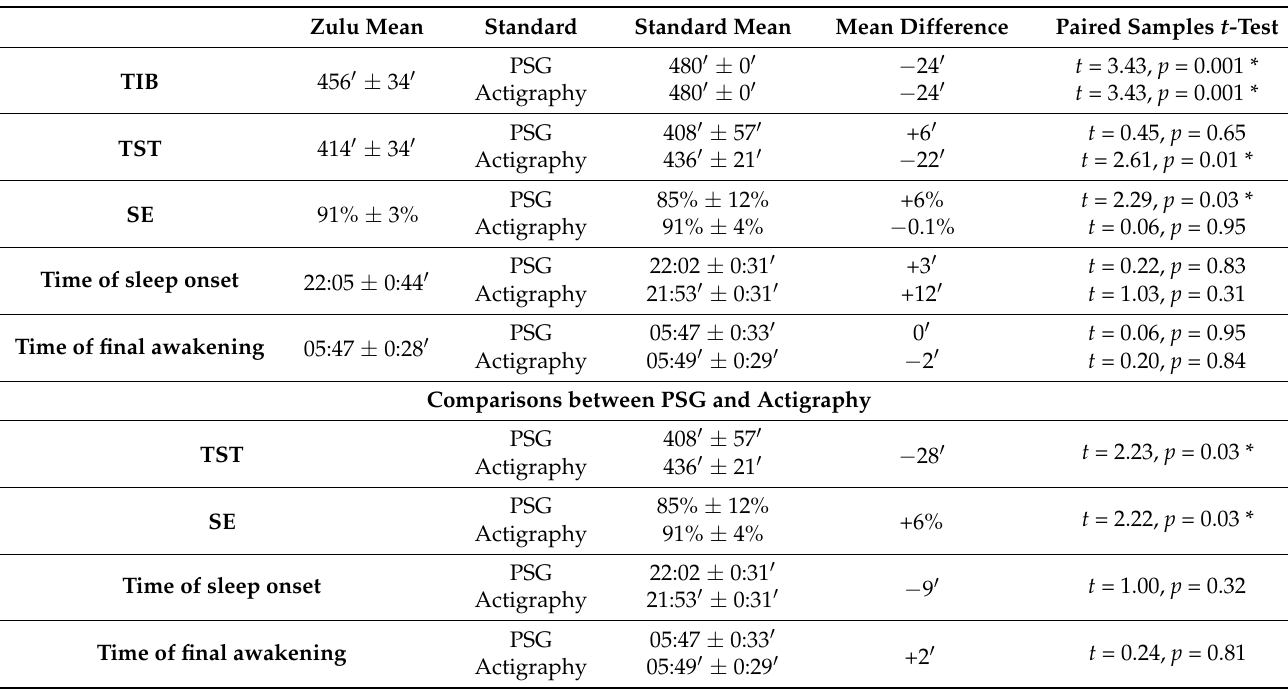
Table 3. Comparison of Zulu watch sleep summary statistics against the PSG and actigraphy